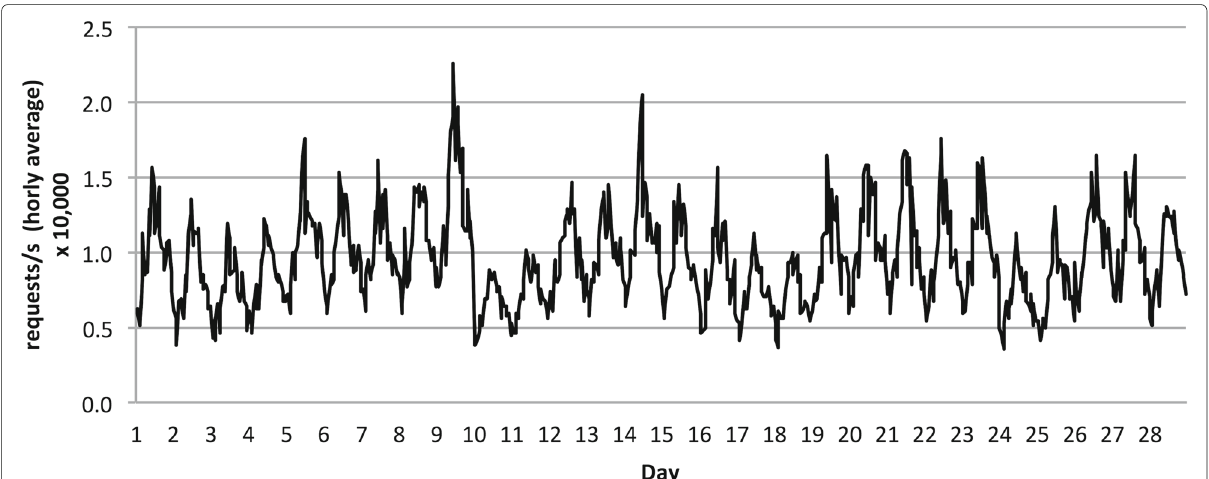
Fig. 3 Summary of input training data. This graph displays the input data used for the training of the SVM-based forecasting model presented in this work. This data were obtained from real web service logs from the Complutense University of Madrid and were gathered over a four-week period on an hourly basis. To emulate a server with high data traffic load, the data collected have been extrapolated one order of magnitude. These input training data represent the hourly average load (expressed in requests per second) of the server for a 4-week period (i.e., N = 672 hours)